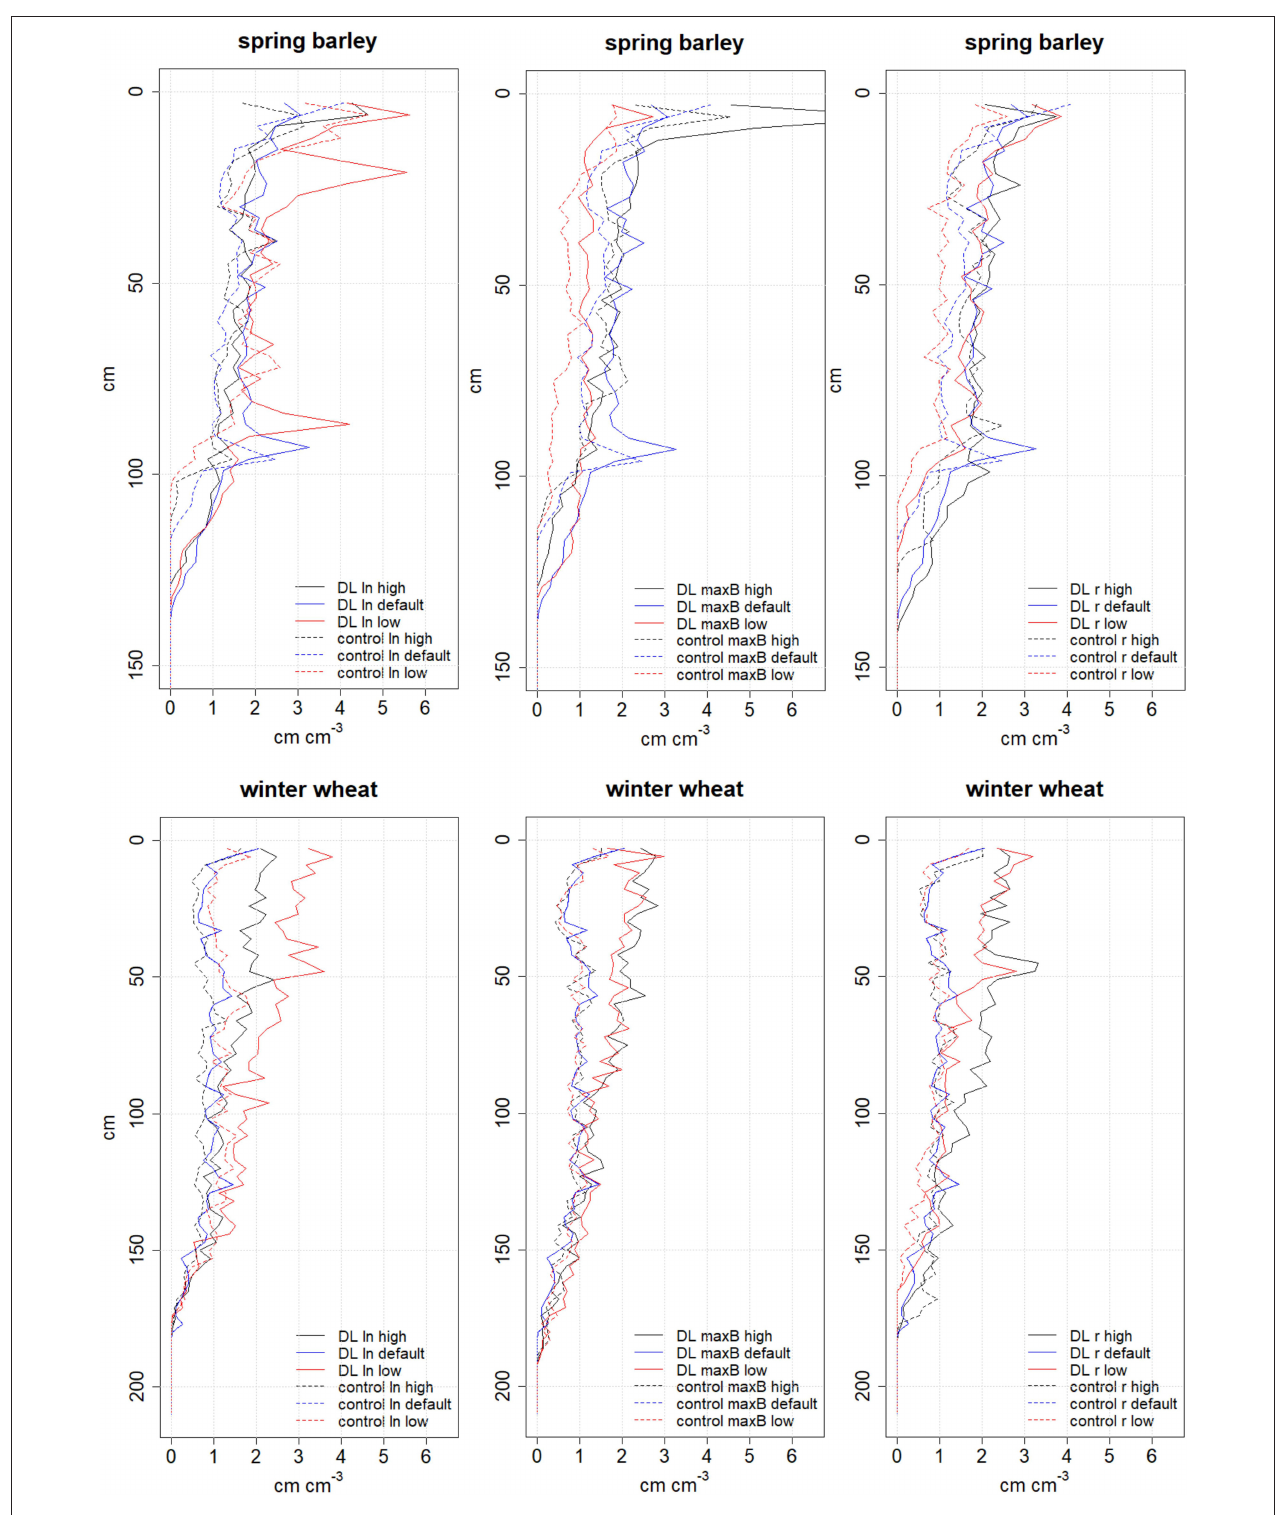
FIGURE 4 | Simulated RLD in cm cm − 3 at flowering of spring barley (top panel) in 2019 and winter wheat (bottom panel) in 2019/20 for phenotypic diversity of root traits using the coupled SIMPLACE-CRootbox model. Applied parameters: ln: length between lateral branches in cm (wheat: low: 1.5, default: 2, and high: 2.5; barley: low: 0.65, default: 0.85, and high: 1); maxB: maximal number of basal roots (wheat: low: 10, default: 20, and high: 30; barley: low: 2, default: 5, and high: 7), and r: initial tip elongation rate (wheat and barley: low: 5, default: 7, and high: 9). For root nomenclature, see Zobel and Waisel (2010).